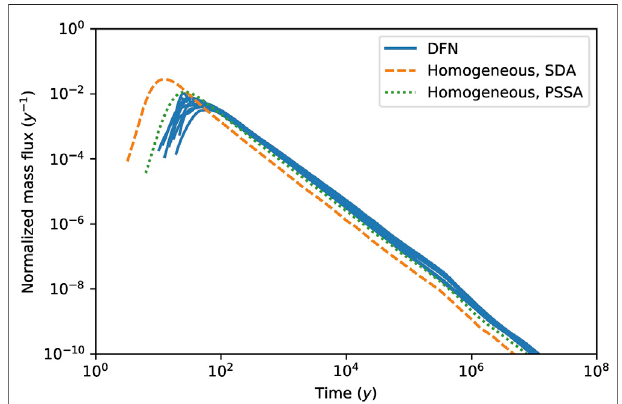
FIGURE 7 | Conservative case : breakthrough curves of a non-sorbing non-decaying radionuclide computed using transport pathways obtained using the different realisations of the DFN model (blue continuous curves) compared with the calculation carried out using the single straight transport pathways derived from the homogeneous plane model and with downscaling applied using the standard algorithm (SDA) (orange dashed line) and with downscaling applied using the projected sub-segment algorithm (PSSA) (green dotted line).